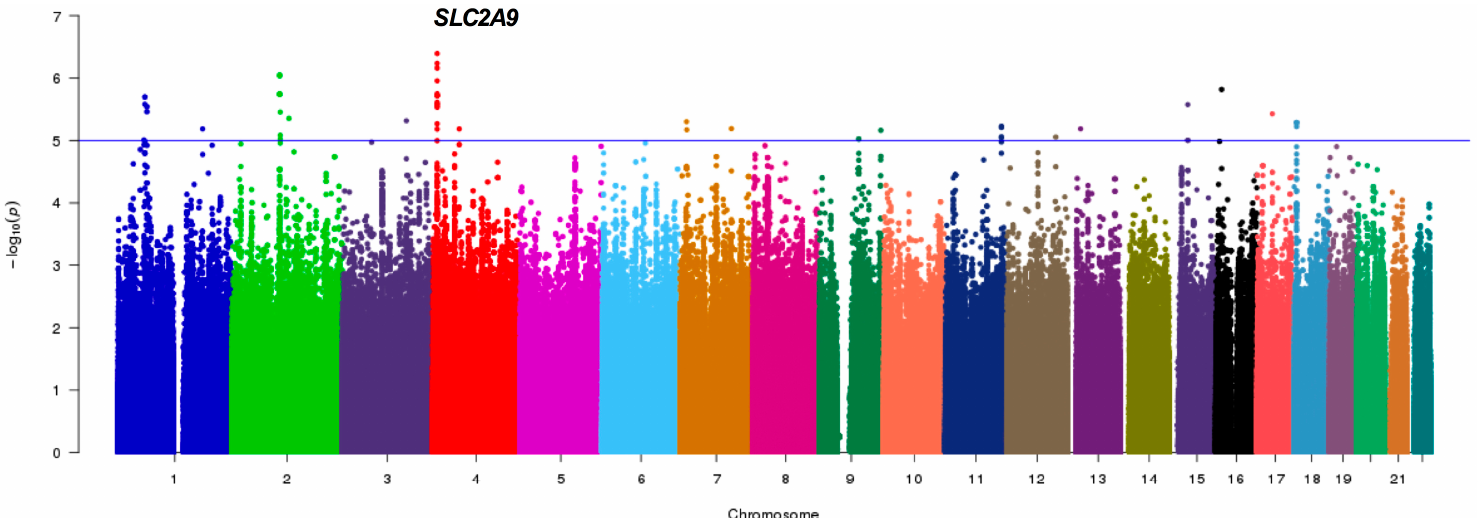
Figure 1. Pilot GWAS for the Serum Uric Acid (SUA) levels in the discovery sample. Manhattan plot for SUA showing the -log10 transformed p -value of SNPs for 411 Mexican postmenopausal women from HWCS. The blue line indicates the established threshold value of p < 1.0 × 10 − 5 . The gene closest to the SNP with the lowest p -value is indicated.